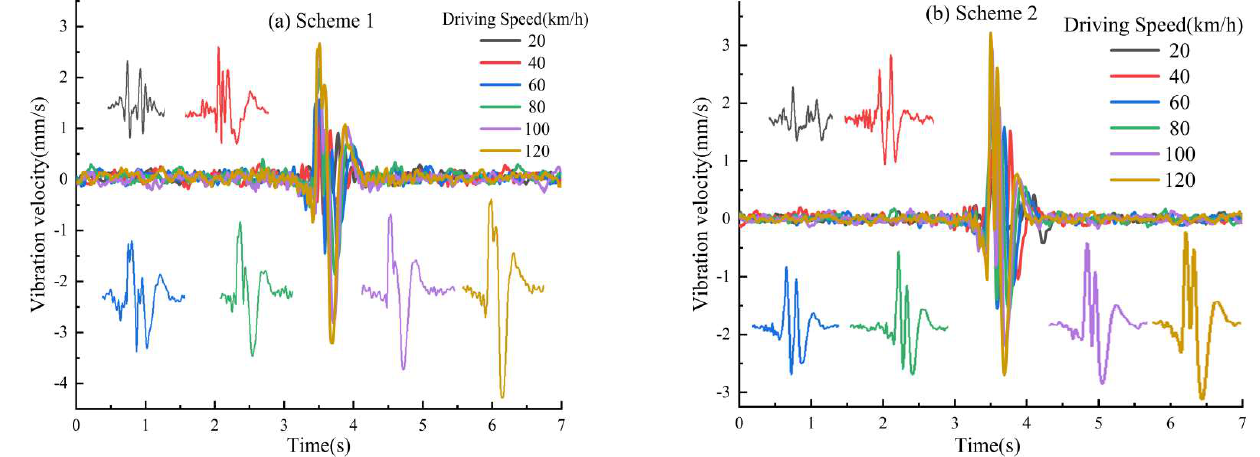
Figure 5. Time-domain curve of vibration velocity.